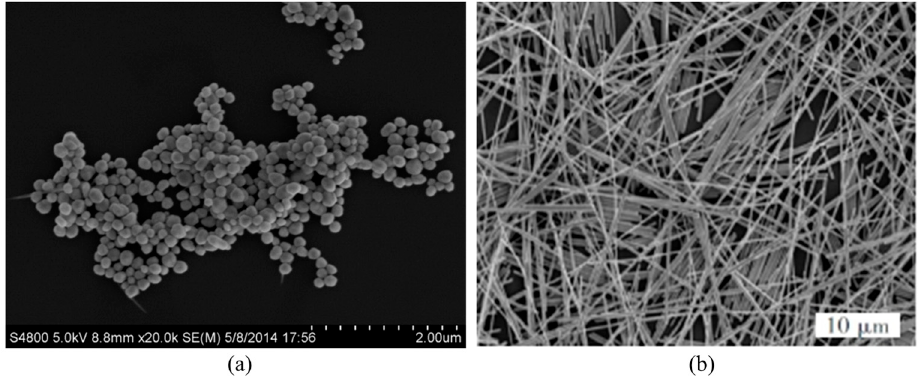
Figure 1. SEM images of the synthesized ( a ) Ag NPs and ( b ) Ag NWs.